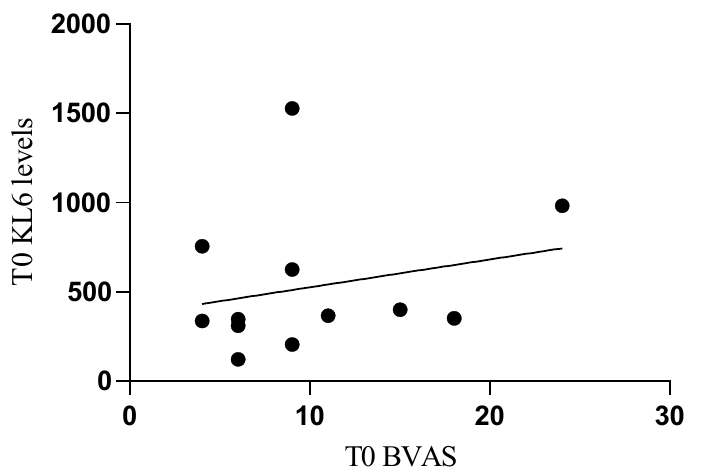
Figure 4. The correlation between serum concentrations of KL-6 at T0 and T0 BVAS (r = 0.578, p = 0.044) in AAV patients.